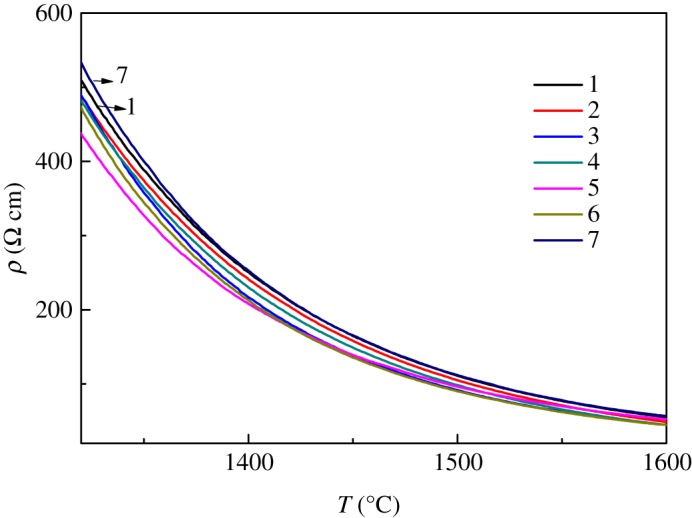
Molten resistivity curves of TFT-LCD substrate glass.